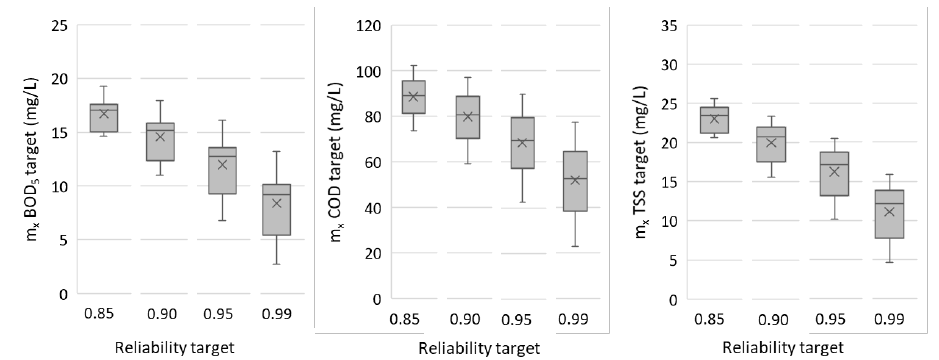
Figure 7. Target mean value (m x ) of BOD 5 , COD, and TSS effluent concentrations for achieving different reliability targets in 7 CAS-WWTPs based on 5-year data.